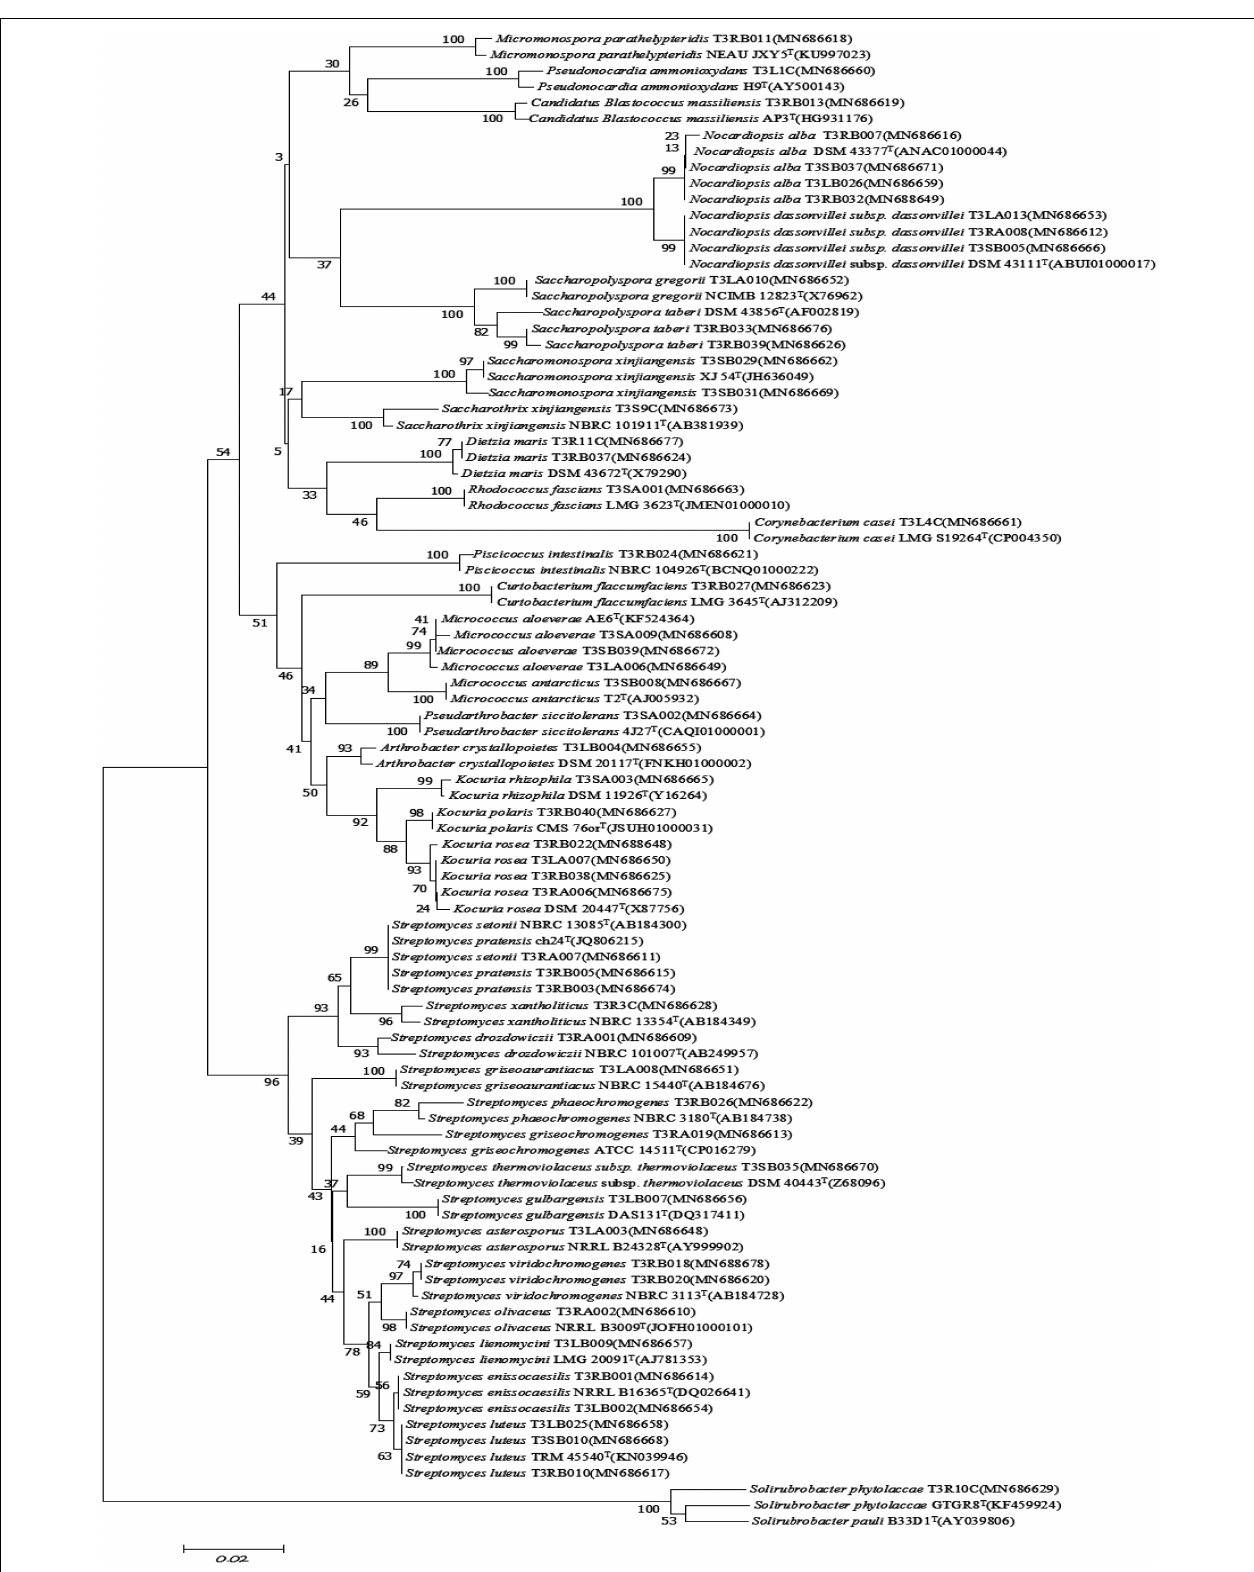
FIGURE 4 | Neighbor-joining tree based on 16S rRNA gene sequences showing relationships between the endophytic actinomycetes (isolated from T. roseus Schipcz. in Ili) and the nearest type strains. The bar represents 2% sequence divergence.